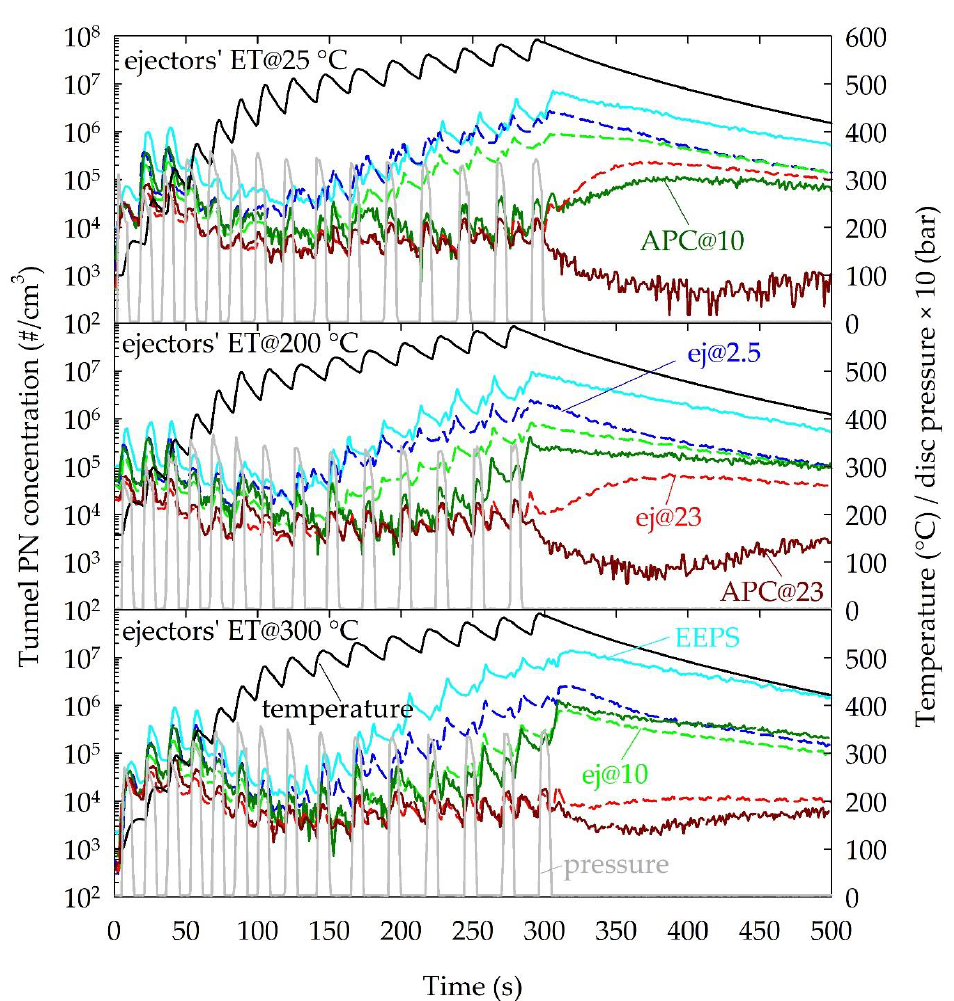
Figure 11. Comparison of real time emission traces over three repetitions of mode D with ECE pads, at di ff erent temperature settings of the ET of the ejectors’ dilution system. In addition to the CPC traces, the total number concentrations measured with the EEPS are also shown to illustrate the repeatability of total particle number emissions between repetitions. The pressure and disc temperature traces are also